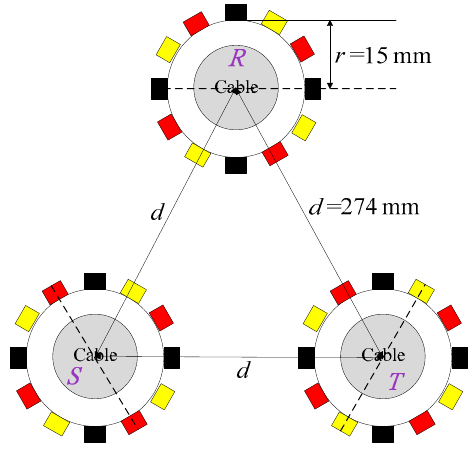
Figure 4. Geometry of three-phase cables and arrangement of sensor modules. Table 4. Current errors of the proposed HCT when three-phase currents are balanced and are 5% of rated current.